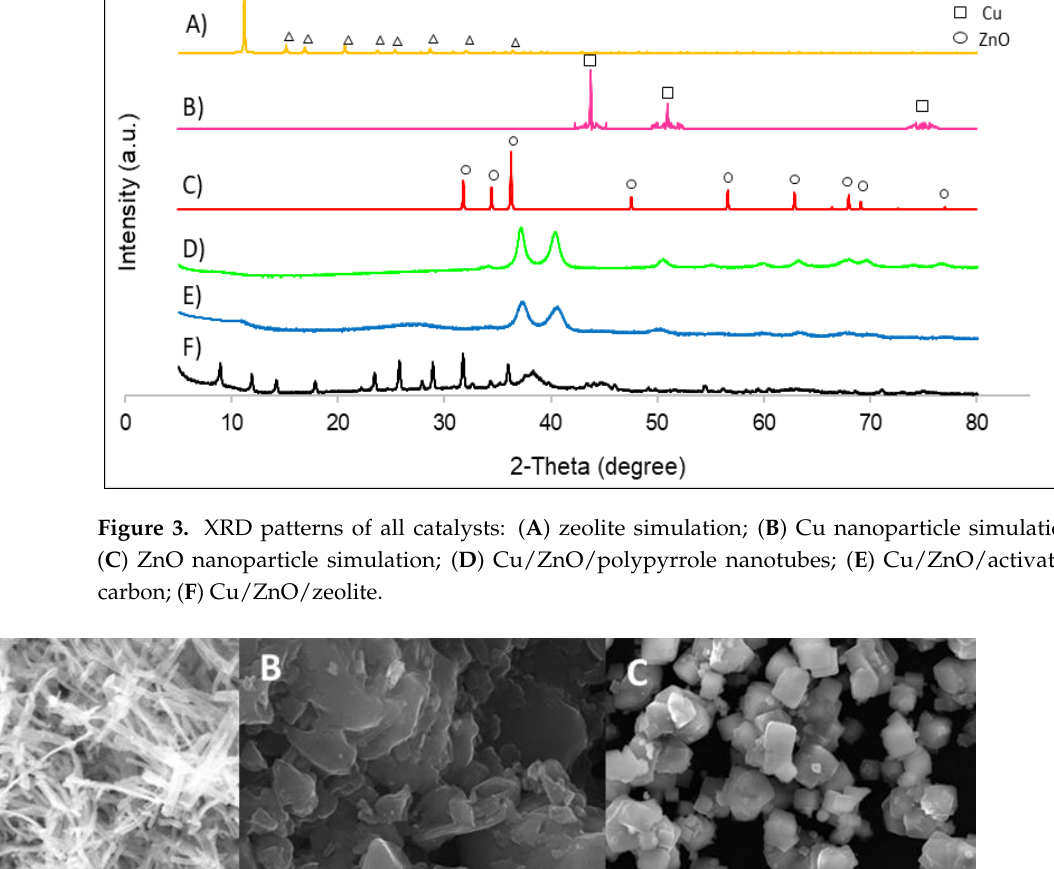
Figure 3. XRD patterns of all catalysts: ( A ) zeolite simulation; ( B ) Cu nanoparticle simulation; ( C ) ZnO nanoparticle simulation; ( D ) Cu/ZnO/polypyrrole nanotubes; ( E ) Cu/ZnO/activated carbon; ( F ) Cu/ZnO/zeolite.